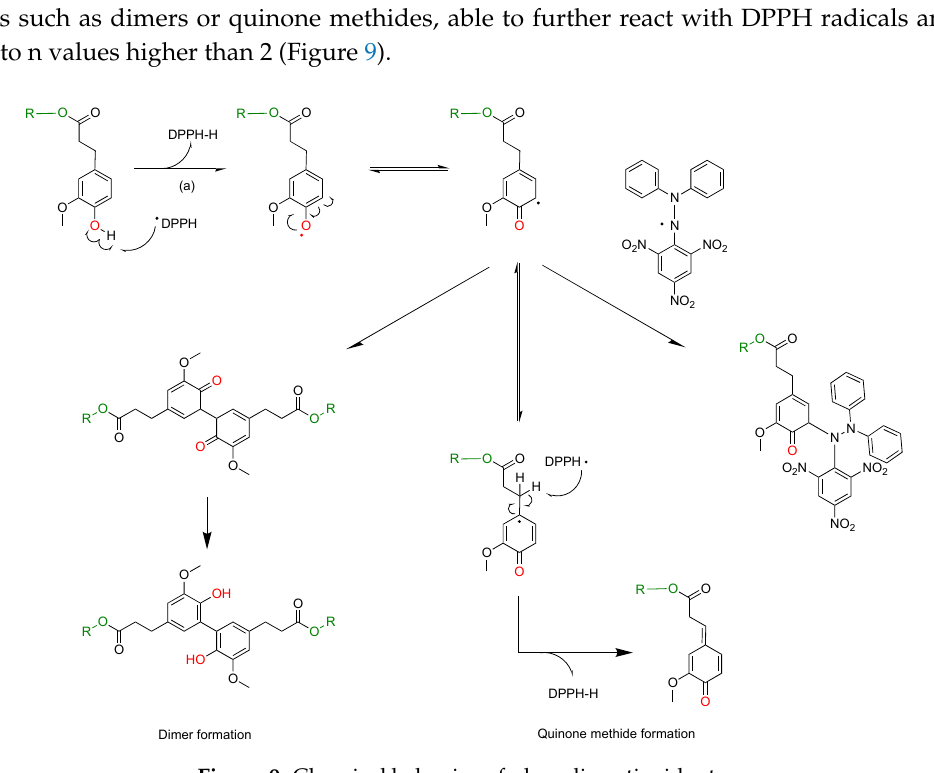
Figure 9. Chemical behavior of phenolic antioxidants.